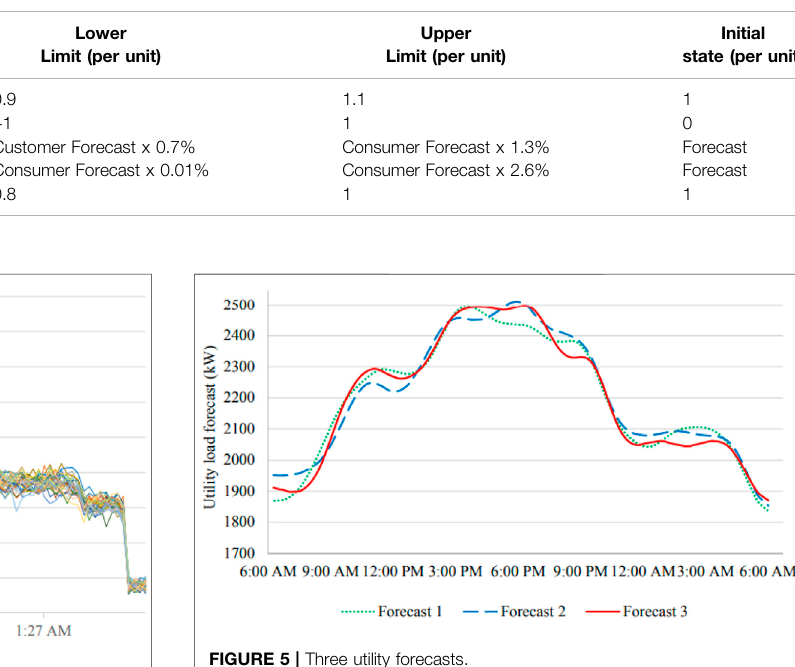
FIGURE 4 | Consumer demands forecasts.